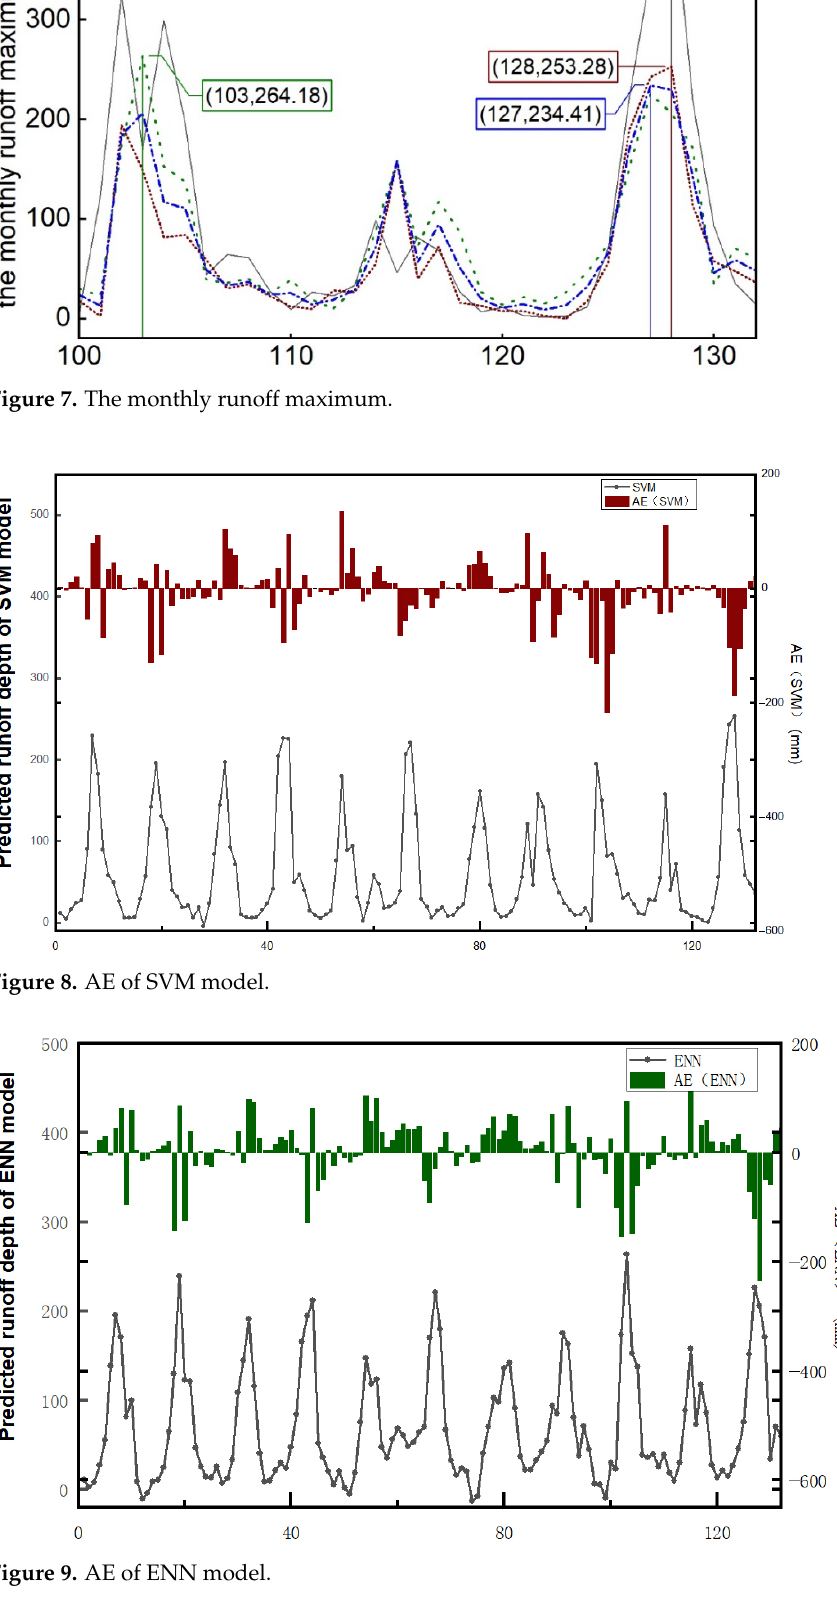
Figure 9. AE of ENN model.